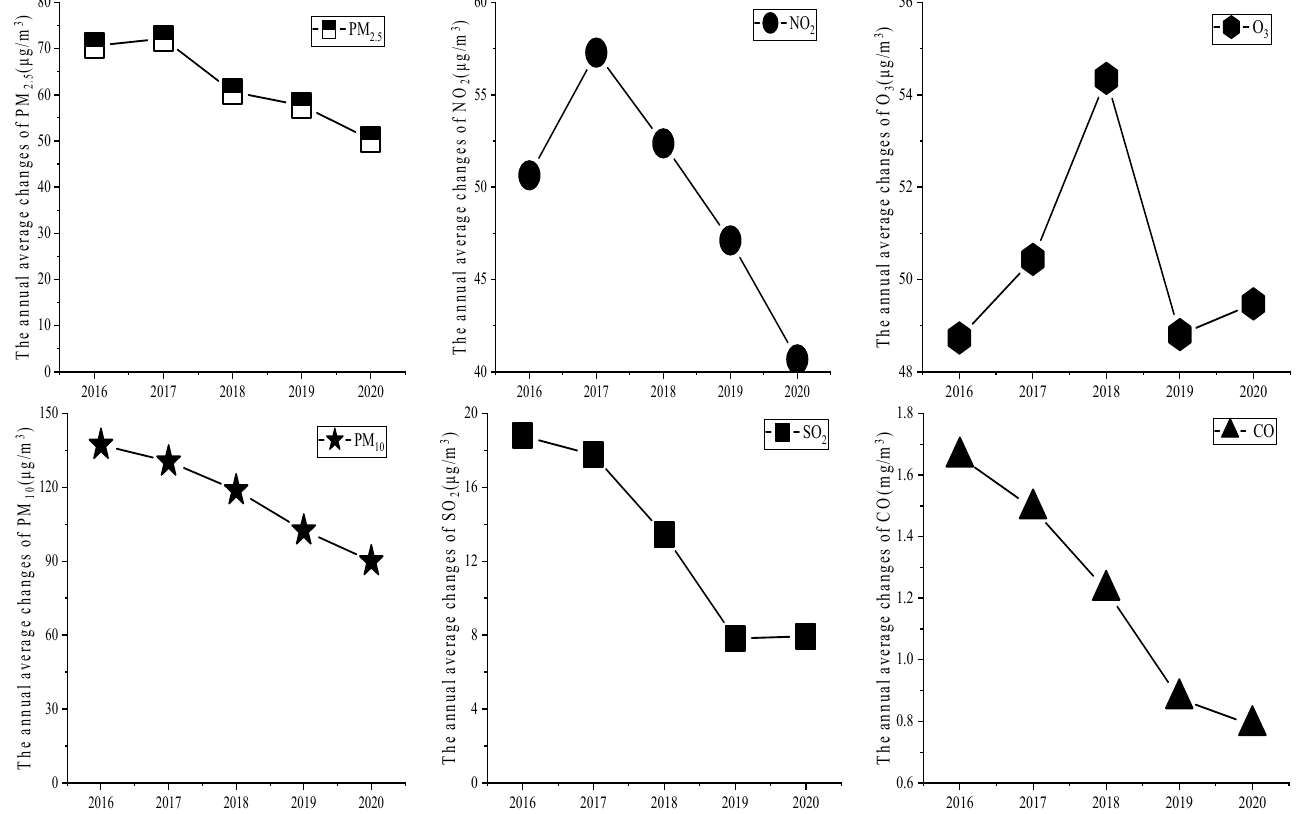
Figure 6. Trends of annual average changes in quantities of various pollutants.